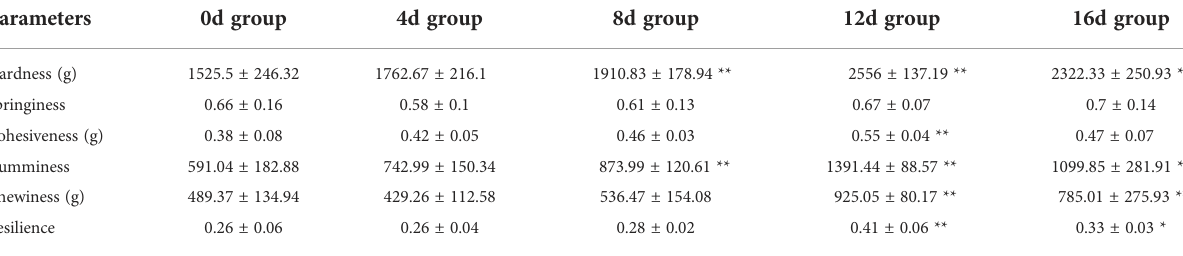
TABLE 1 The effects of short-term swimming exercise on the muscle texture parameters of this hybrid species (N = 18, mean ± SD).